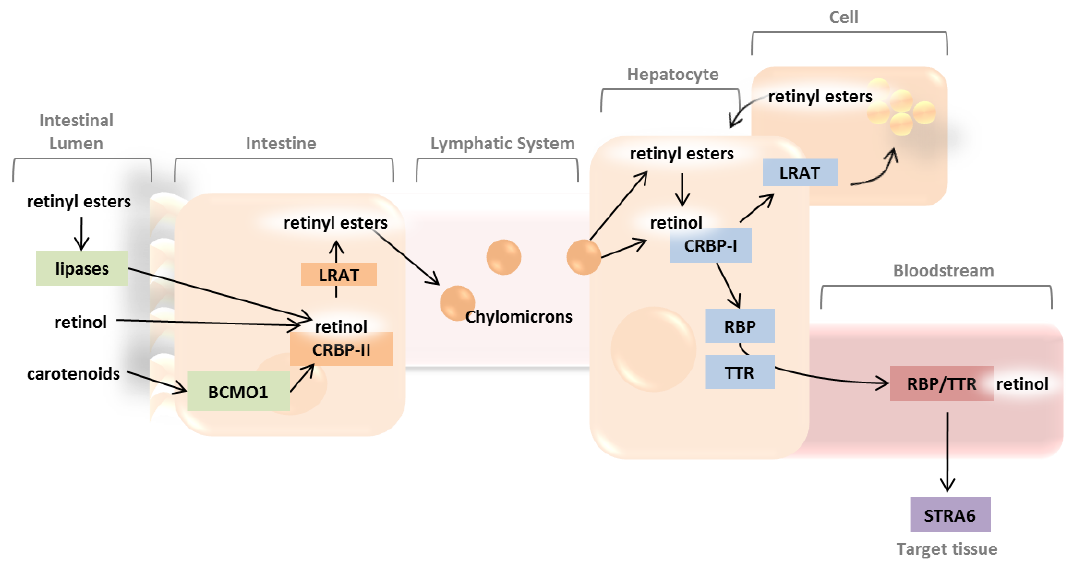
Figure 1. The metabolism of carotenoids and retinoids begin in the intestinal lumen, where provitamin A and retinoid molecules are absorbed. Retinyl esters are transported to the liver via the lymphatic system, while retinol is transported through the bloodstream before delivery to target tissues, such as the